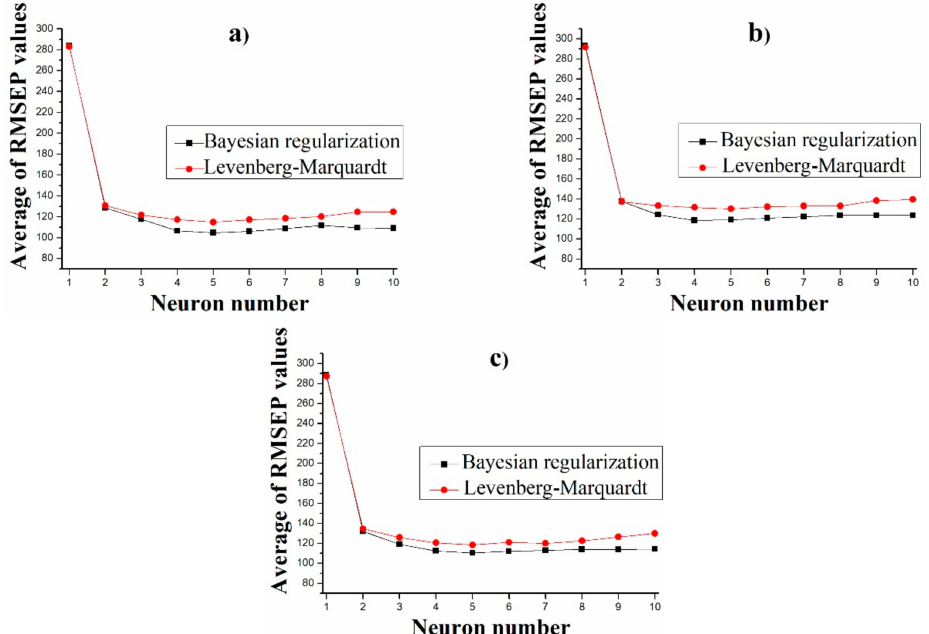
Figure 7. Average RMSEP values of predictions using DR and HPMC content predicted from ( a ) Raman, ( b ) NIR and ( c ) Raman and NIR spectra as input.